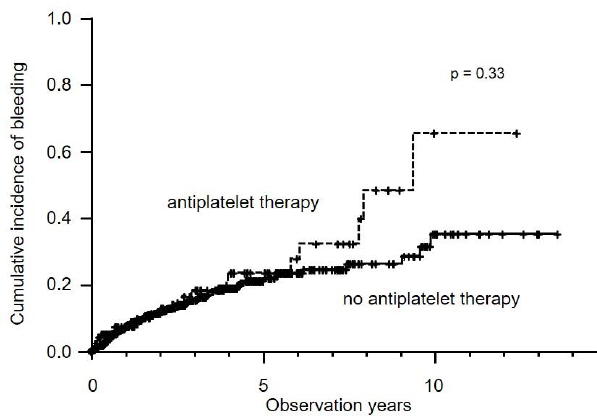
Figure 4. Cumulative incidence of hemorrhagic events in all patients. Five-year incidence rates for antiplatelet therapy (dotted line) and no antiplatelet therapy (solid line) were 23.1% and 21.4%, respectively ( p = 0.33).